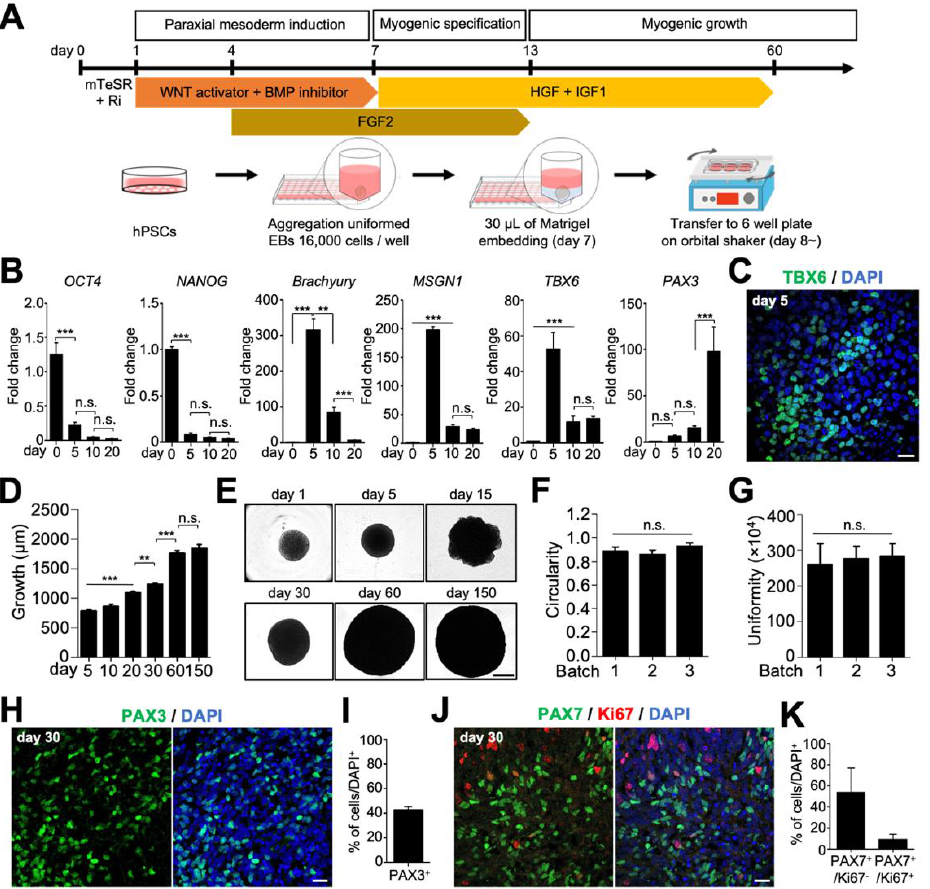
Figure 1. Generation and characterization of hSkMOs from hPSCs at early stages. ( A ) Schematic depicting the overall strategy to generate human skeletal muscle organoids (hSkMOs). ( B ) The gene expression of pluripotent ( OCT4 , NANOG ), mesodermal posterior somitic ( Brachyury , MSGN1 , TBX6 ), and myogenic progenitor ( PAX3 ) markers at different time points (days 0, 5, 10, and 20) of hSkMOs were identified by quantitative real-time reverse transcription-polymerase chain reaction (qRT-PCR) analysis. The qRT-PCR data were normalized to GAPDH expression. ( C ) Cryosection of the hSkMOs at day five stained for T- Box transcription factor 6 (TBX6). Scale bar, 20 μm. ( D ) The growth diameter demonstrates the average size (mean ± standard error of the mean (s.e.m.)) of hSkMOs from three batches. ( E ) The representative images of hSkMOs morphology are shown at each time point. Scale bar, 500 μm. ( F ) The circularity was calculated for each organoid in each batch using ImageJ software; mean ± s.e.m., n = 20. ( G ) Uniformity of hSkMOs was calculated for each